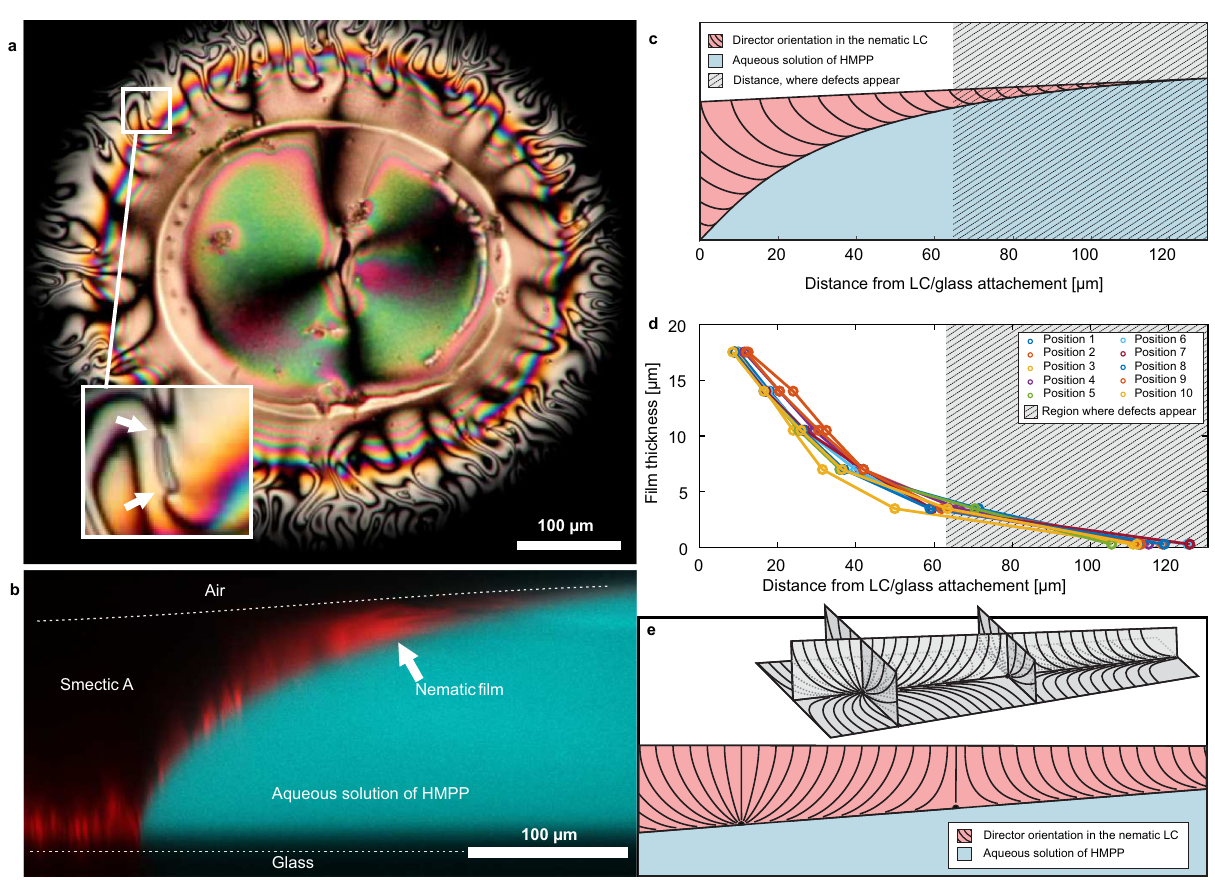
Fig. 1 | Turbulence in a thin wedge-like fi lm of liquid crystal (LC). a A cross- polarized image of a LC fi lm fl oating on aqueous solution of 2-hydroxy-2- methylpropiophenone photoinitiator (HMPP). Due to the continued diffusion of the HMPP from water into the LC, the fi lm has turned nematic, although the tem- peratureis25°C,wherepure8CBissmecticA.Intheouter,corona-likeandcolorful band, topological defects can be observed, each as a set of four dark brushes emerging from a single point (markedintheinset).The colorfulconcentric fringes in the corona band suggest that it has the shape of a thin fi lm that decreases in thickness when going radially outwards (see also Supplementary Movie 2).